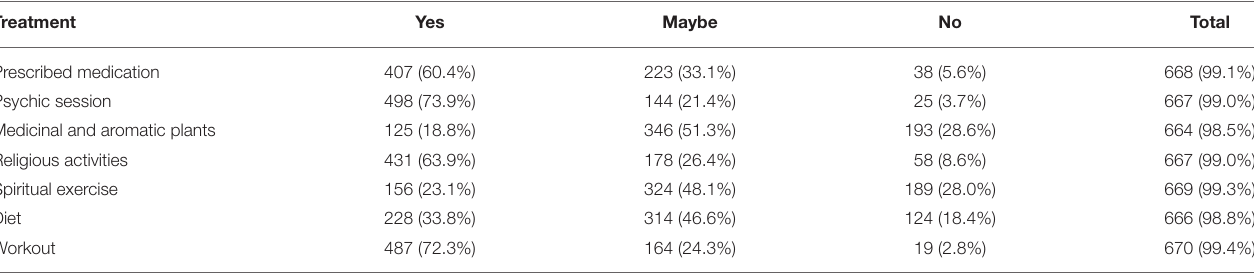
TABLE 5 | Participants perception and beliefs about the possible treatment of psychological disorders.